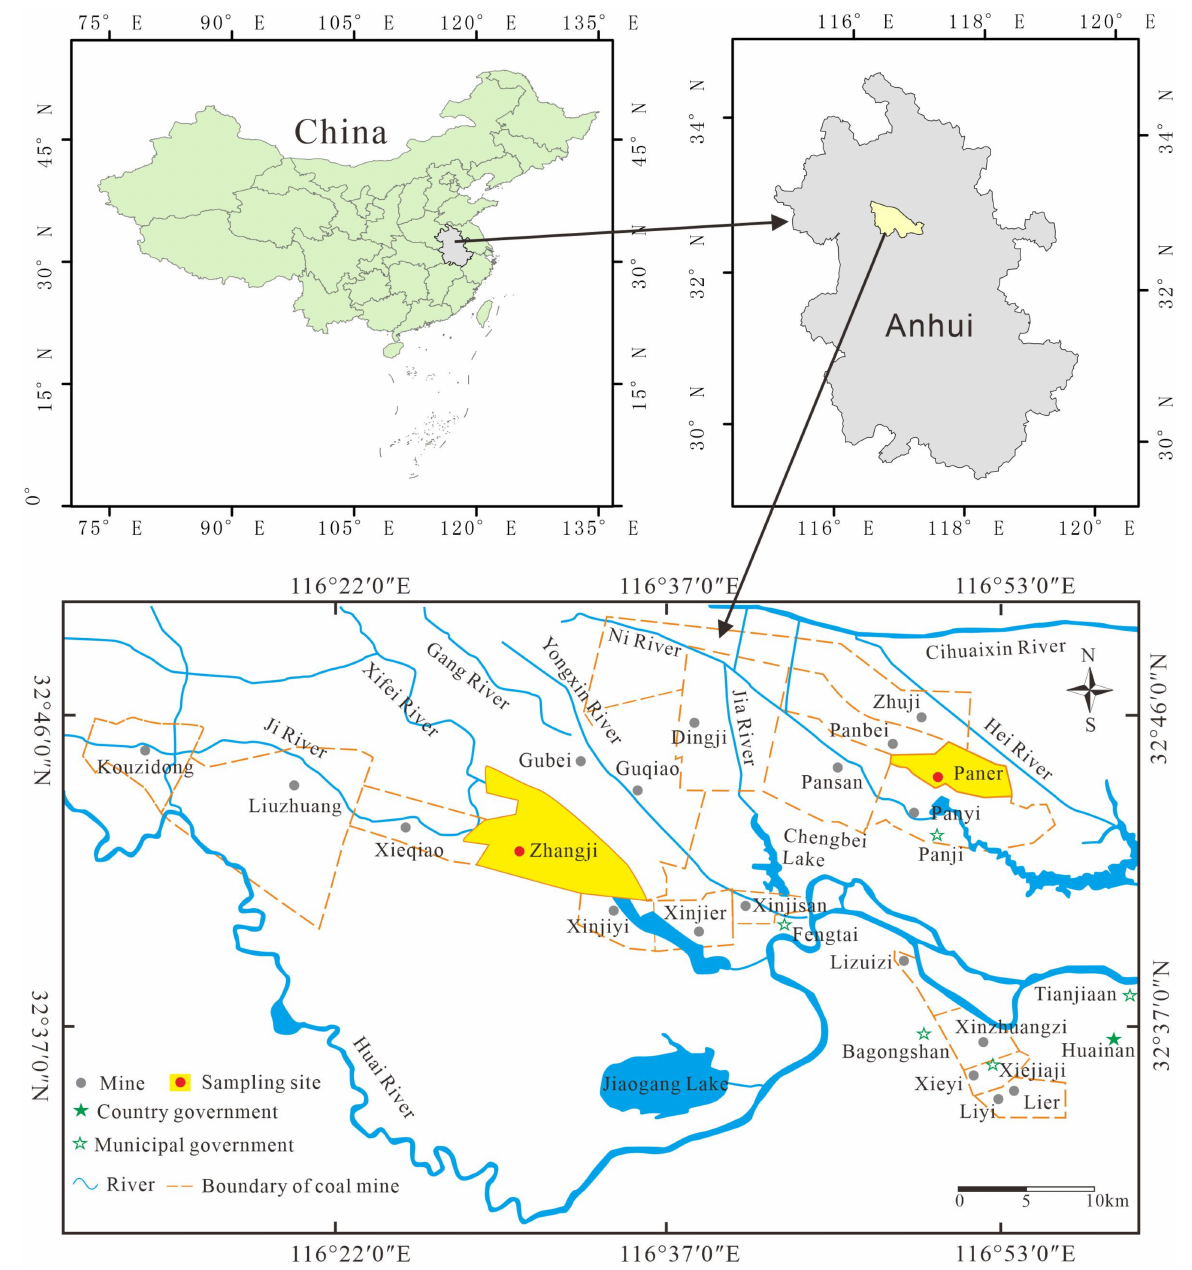
Figure 1. Location map of the Huainan Coalfield,